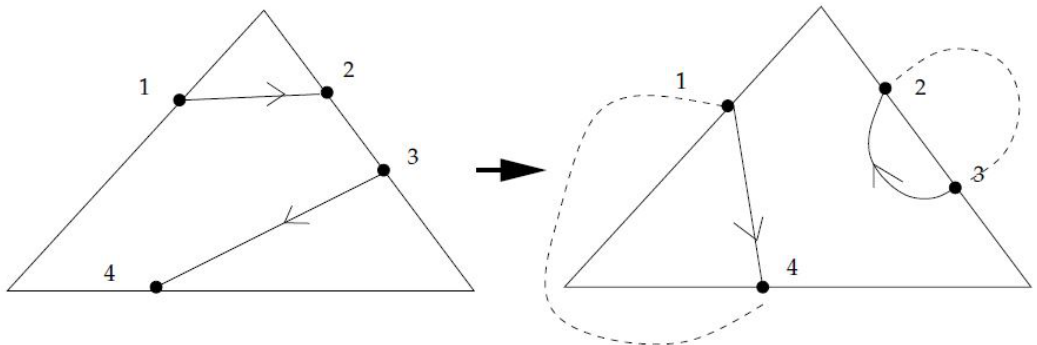
Figure 17. Intersecting closed curves.